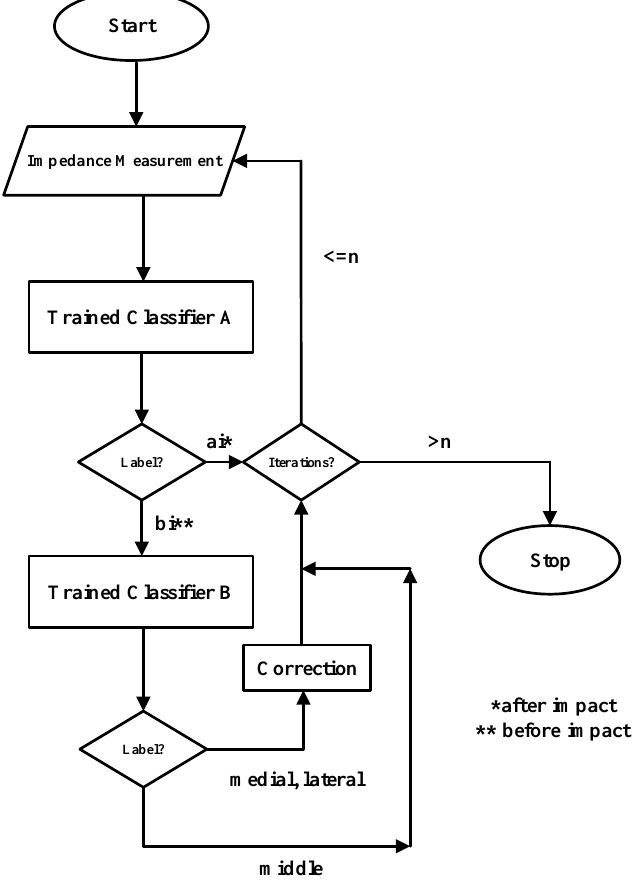
Figure 8. Flow graph for online prediction and